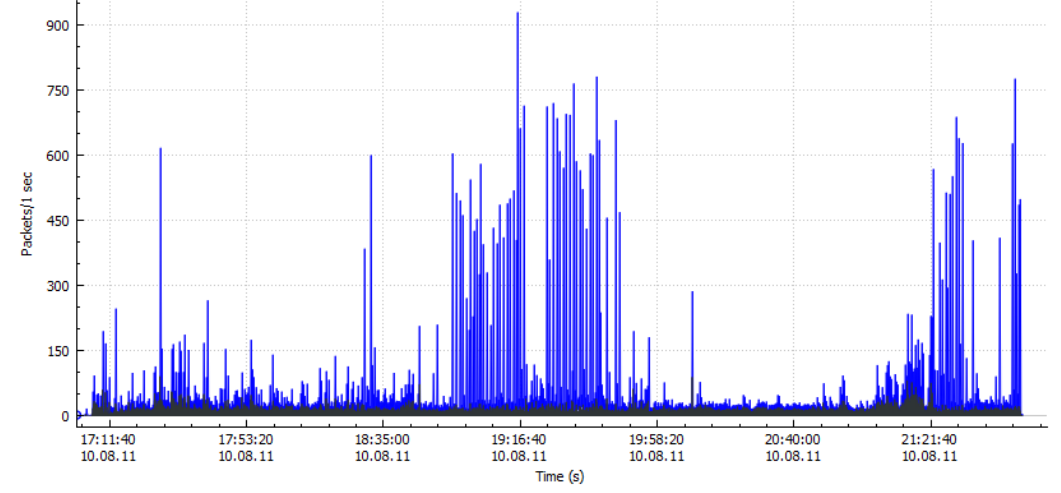
Figure 12. Neris Botnet captured.